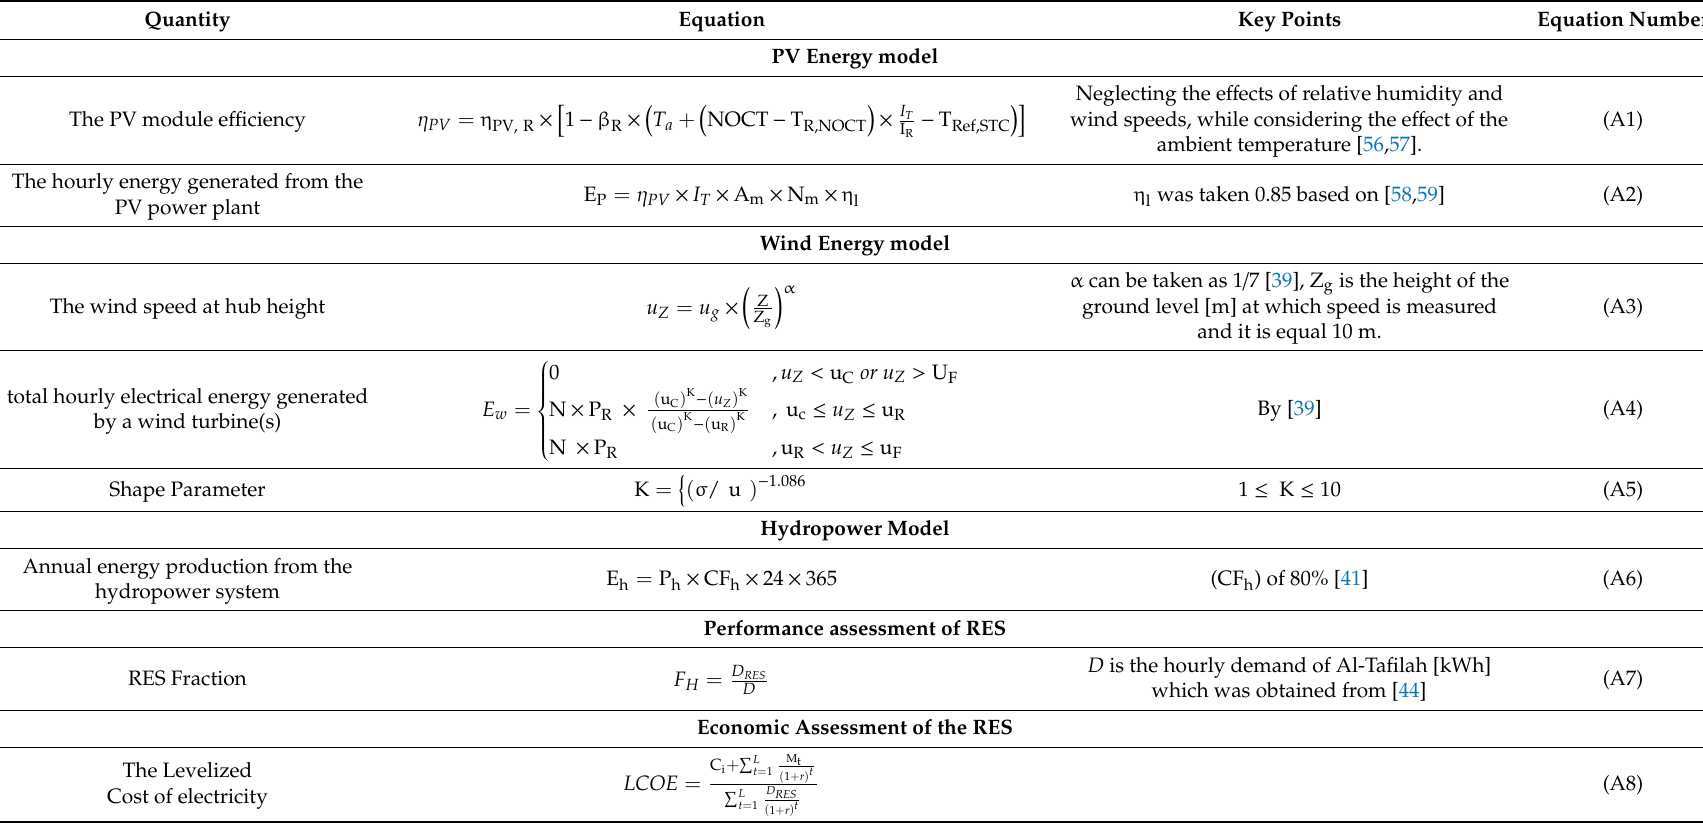
Table A1. System Modelling